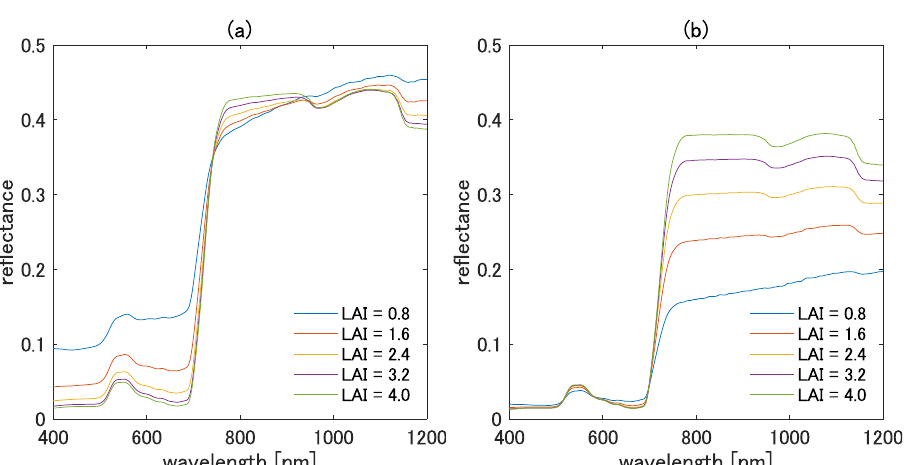
Figure 5. Simulated TOC reflectance spectra for various LAI values with ( a ) bright soil and ( b ) dark